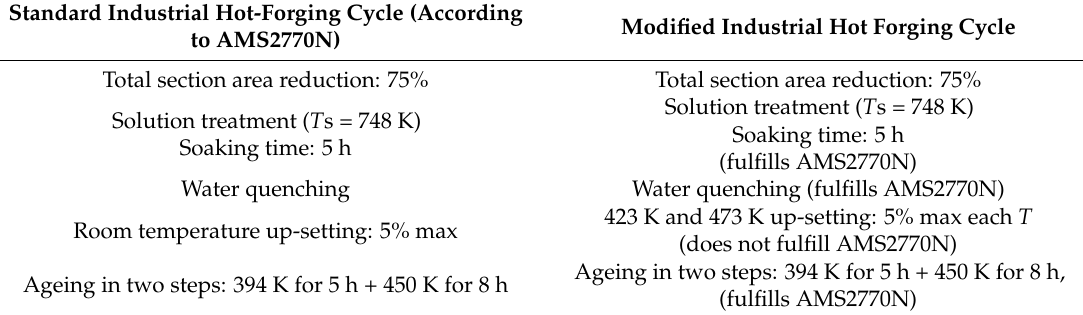
Figure 1. Forging process draft. Table 2. Standard and modified industrial hot-forging cycle for AA7050 alloy.